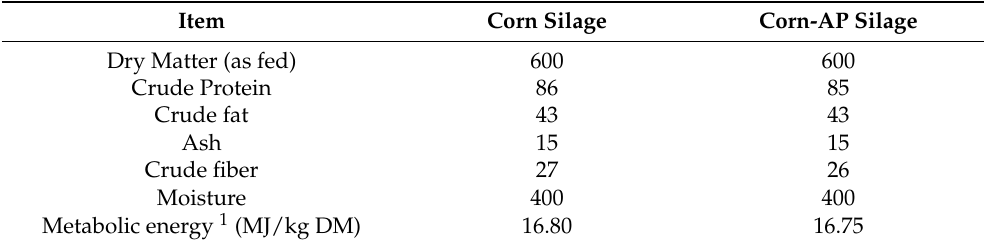
Table 1. Chemical composition of corn and corn-apple pomace (AP) silage (per dry matter-dry matter basis)